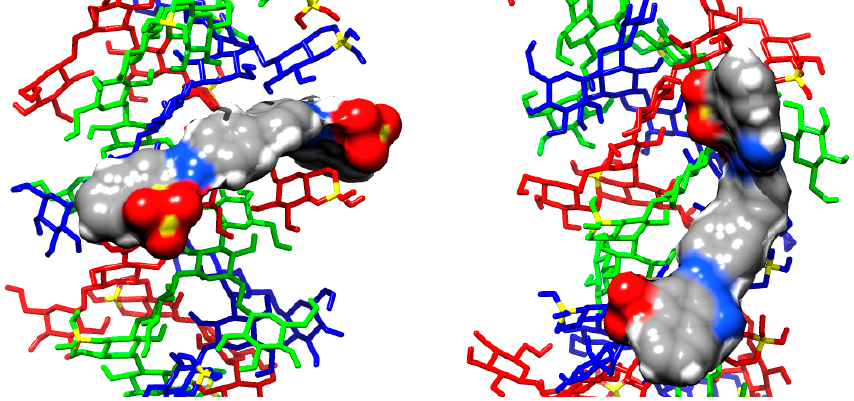
Figure 7. Structures of the complexes sampled during the molecular dynamics (MD) simulations of the triple helix in the presence of CR. The two structures are the more representative of the complexes with perpendicular (on the left) and parallel (on the right) orientation of CR with respect to the triple-helix axis. Sclg is reported with a stick representation, the three strands are coloured in red, blue, and green, respectively. The boron atom is evidenced in yellow. The CR molecules are reported as a surface, coloured by elements.